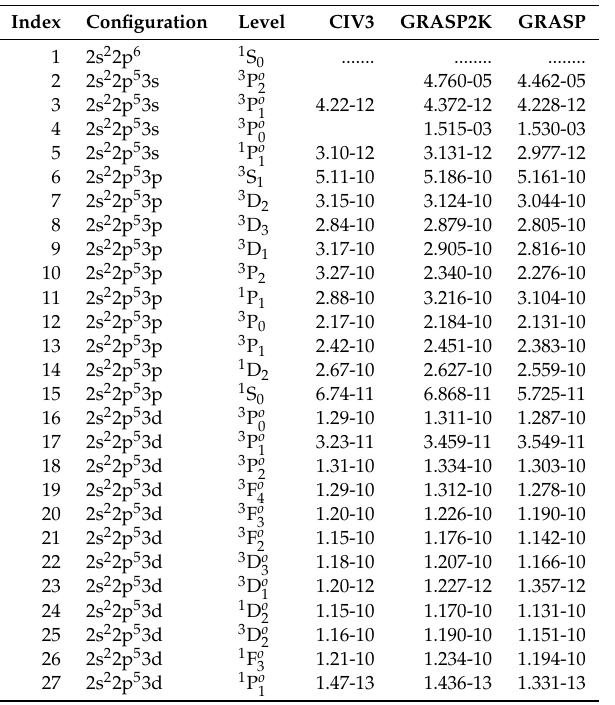
Table 11. Comparison of lifetimes ( τ , s) for the lowest 27 levels of Sc XII. a ± b ≡ a × 10 ± b